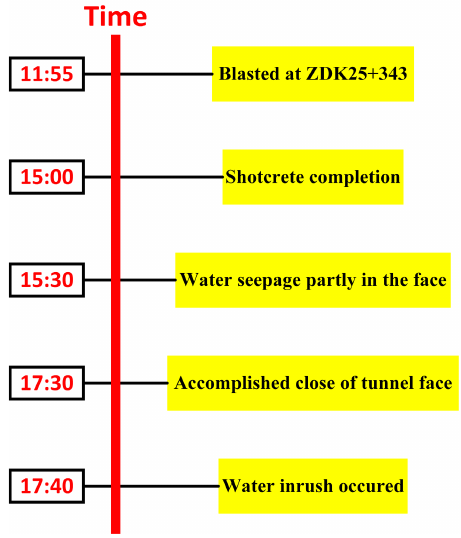
Figure 6. Evolution process of the disaster.